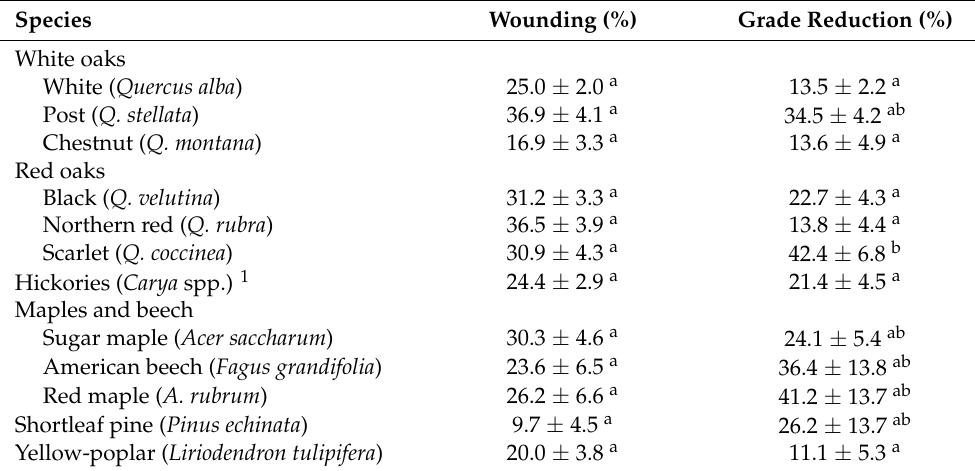
Table 6. Mean ( ± standard error) likelihood of wounding and conditional likelihood of grade reduction assuming wounding for all common species (n > 50). Latin names are given in parenthesis. Species with significantly different likelihoods (Tukey’s HSD test, α = 0.05) are denoted by different superscripted letters.